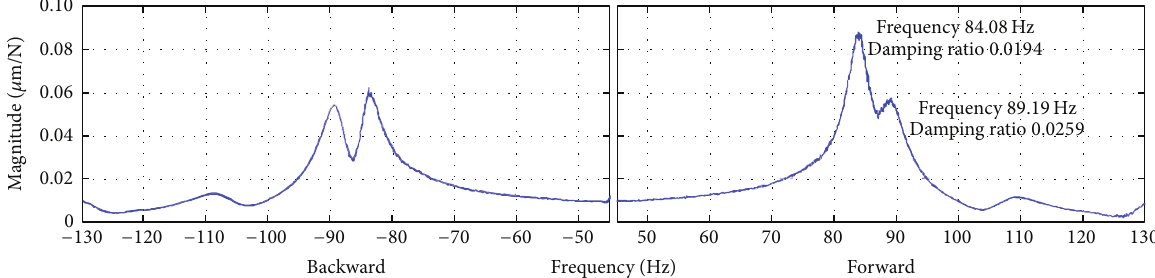
Figure 6: Example of frequency response function (FRF) under sine sweep excitation (5-pad, LOP, preload 0.3, 10,000 rpm).